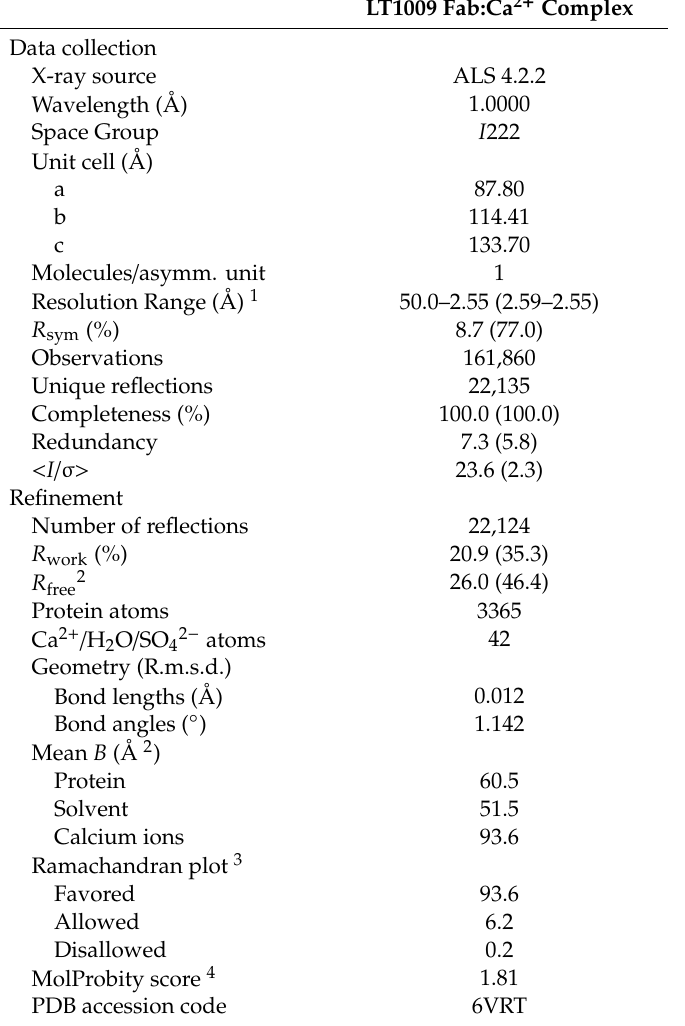
Table 1. X-ray crystallography data collection and refinement